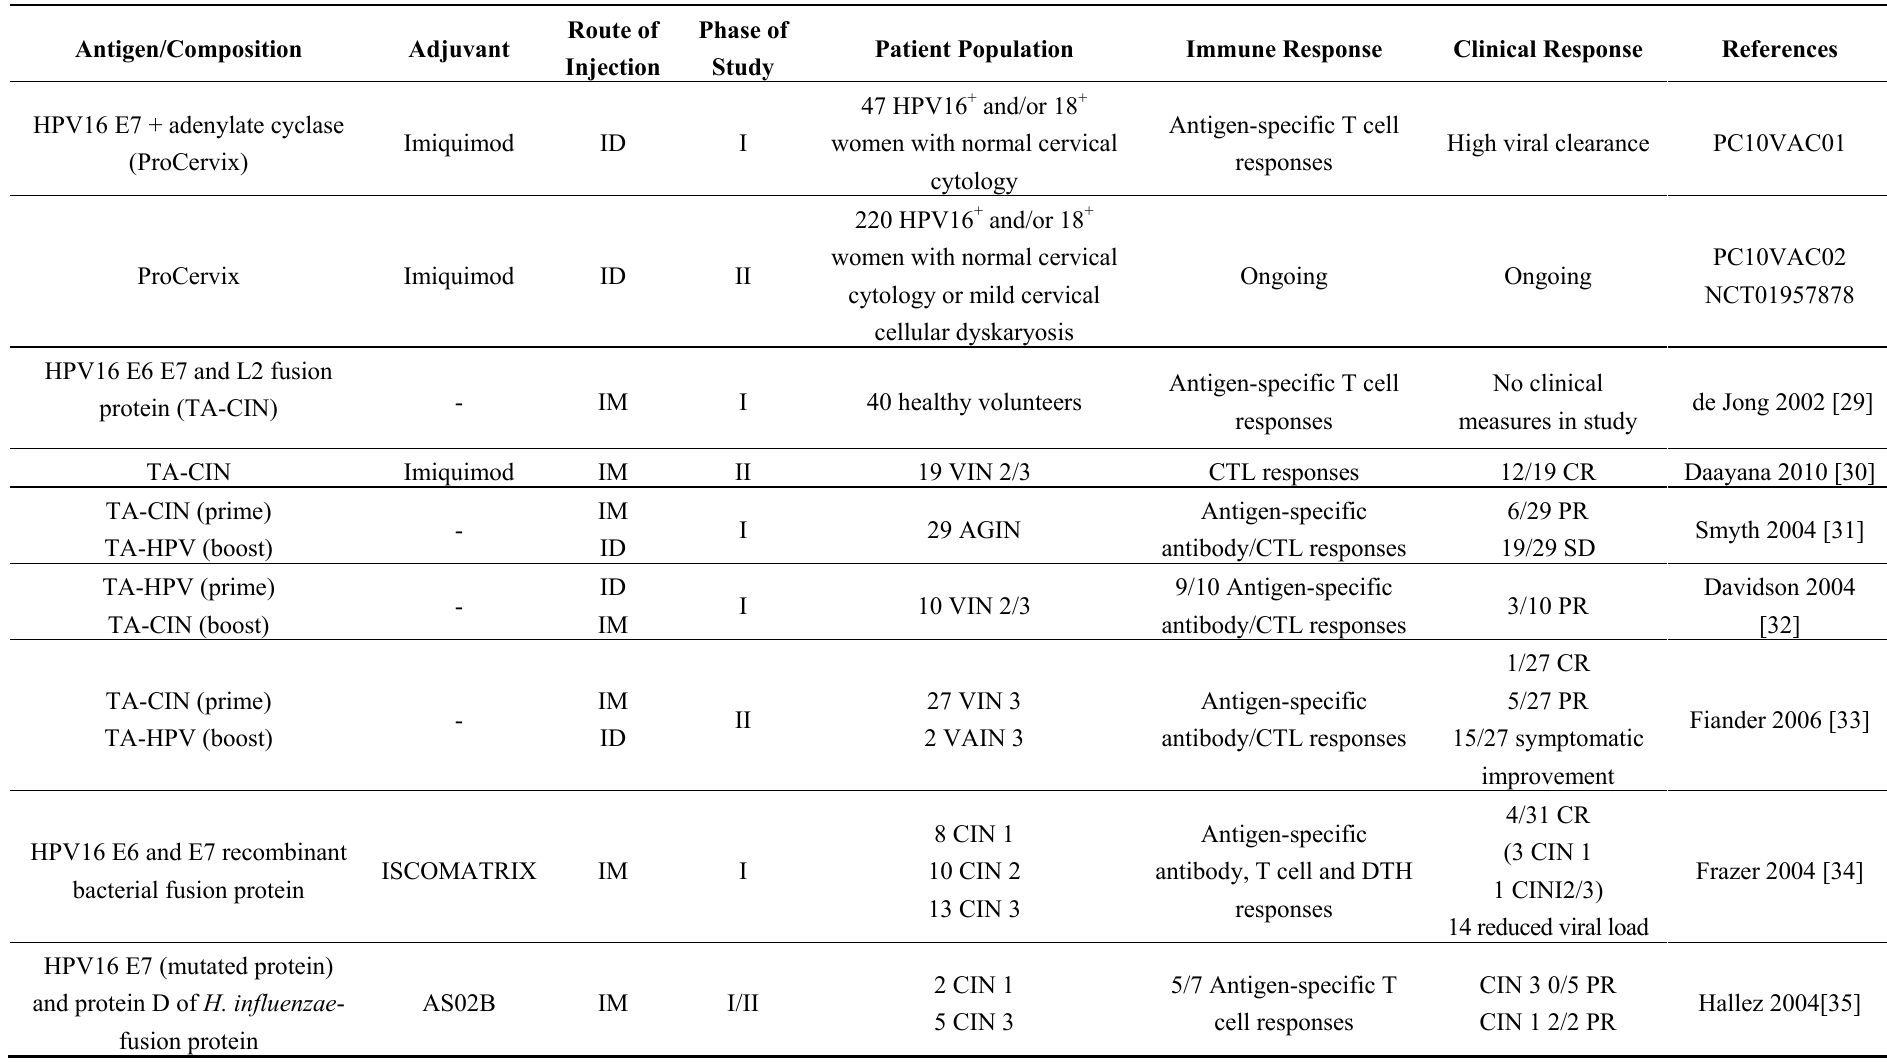
Table 1. Clinical studies with protein-based